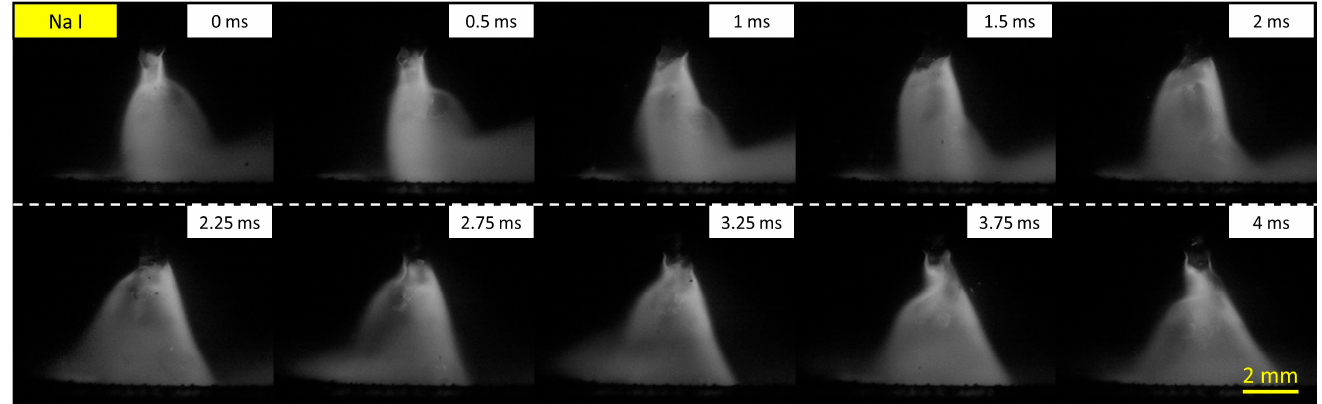
Figure 5. Metal transfer observation using the Na I filter for wire 3 at 320 A welding current.